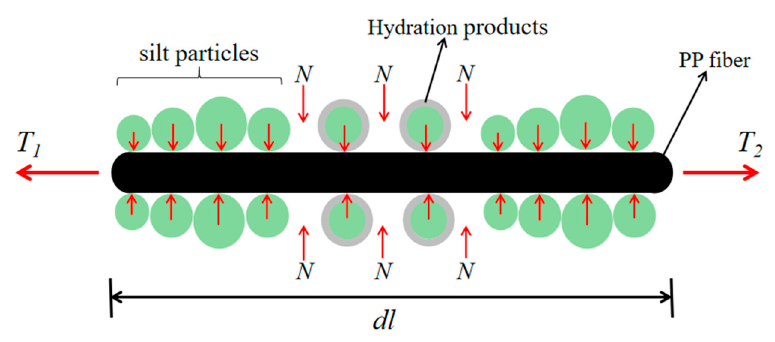
Figure 15. Schematic diagram of the micro-segment of friction reinforcement. Supposing that the length of the micro-segment is dl , the tensile forces T 1 and T 2 are applied at the cross-sections of both ends of the PP fiber, and the cross-sectional area is S. The normal pressure on the outer surface of the PP fiber is N , and the coefficient of friction between the fiber and the soil is µ . The quality of fibers and soil particles is negligible. When the soil is subjected to an external load, the external strain will cause the fiber on the micro-segment to generate tensile stress dT ; then, dT = T 1 − T 2 , assuming that the friction generated on the micro-segment is dF . Then, there